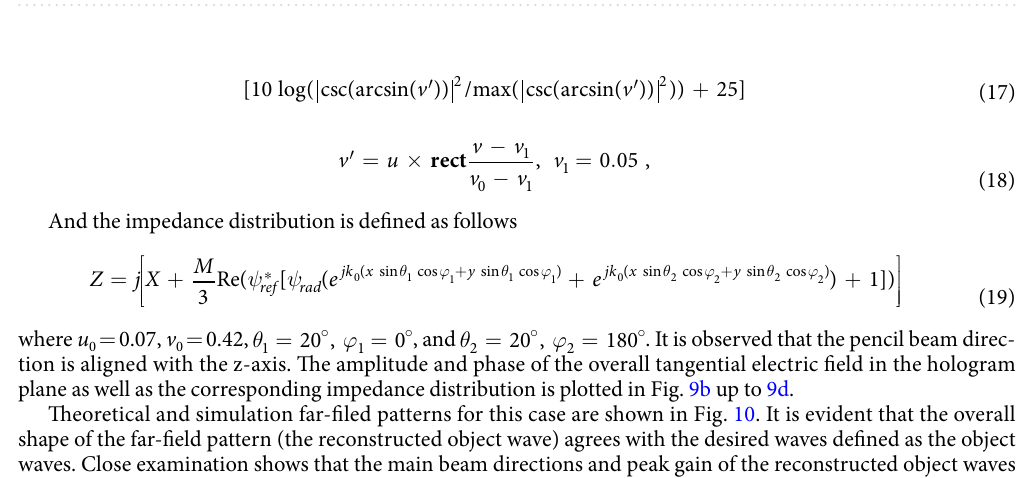
Figure 11. The fabricated three-beam hologram including two squared cosecant beams and one pencil